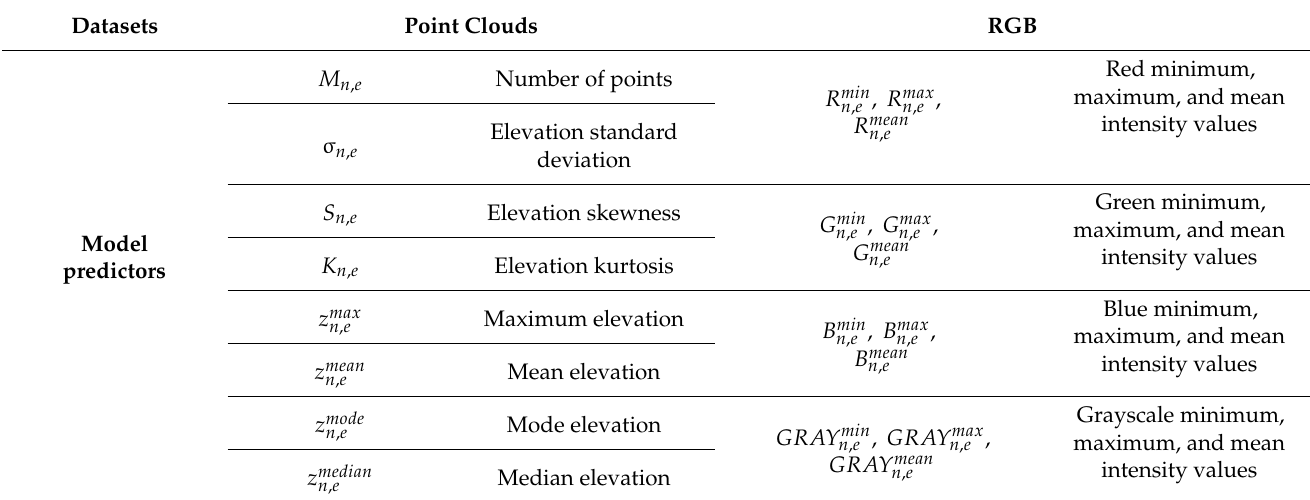
Table 1. List of the model predictors we used to determine vegetation height and density by using the genetic algorithm. By “Point Clouds” we mean the LiDAR- and the Digital Aerial Photogrammetry (DAP)-UAV point clouds.